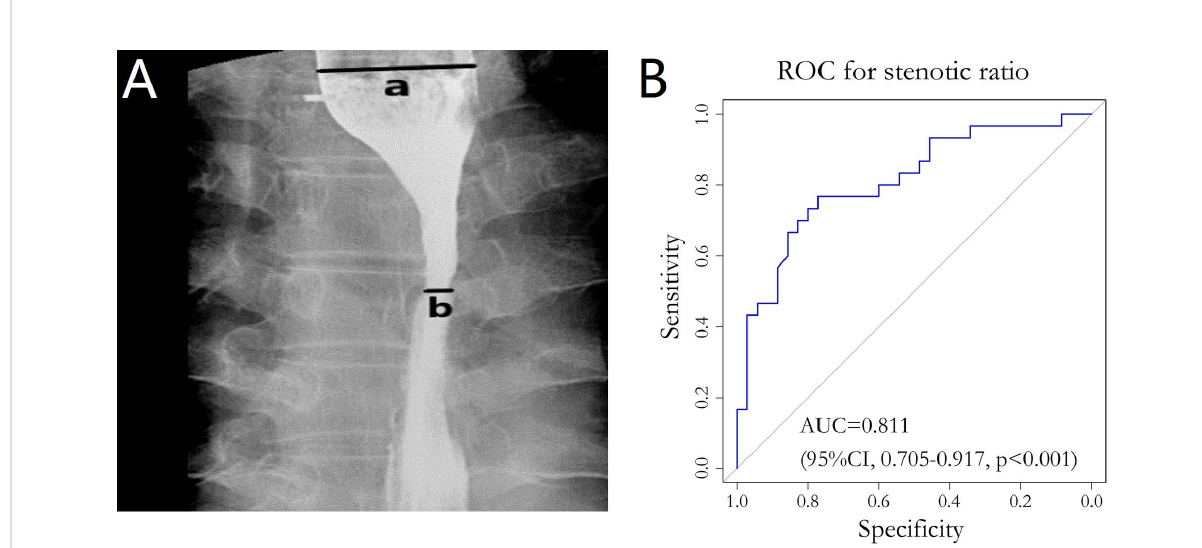
FIGURE 2 (A) Barium esophagography image. The widest part (line a in panel A ) of the oral side and the narrowest part (line b in panel A ) of the primary site were clearly demonstrated. (B) ROC curve for stenotic ratio and the diet group. ROC, Receiver operating Characteristic; AUC, Area under the